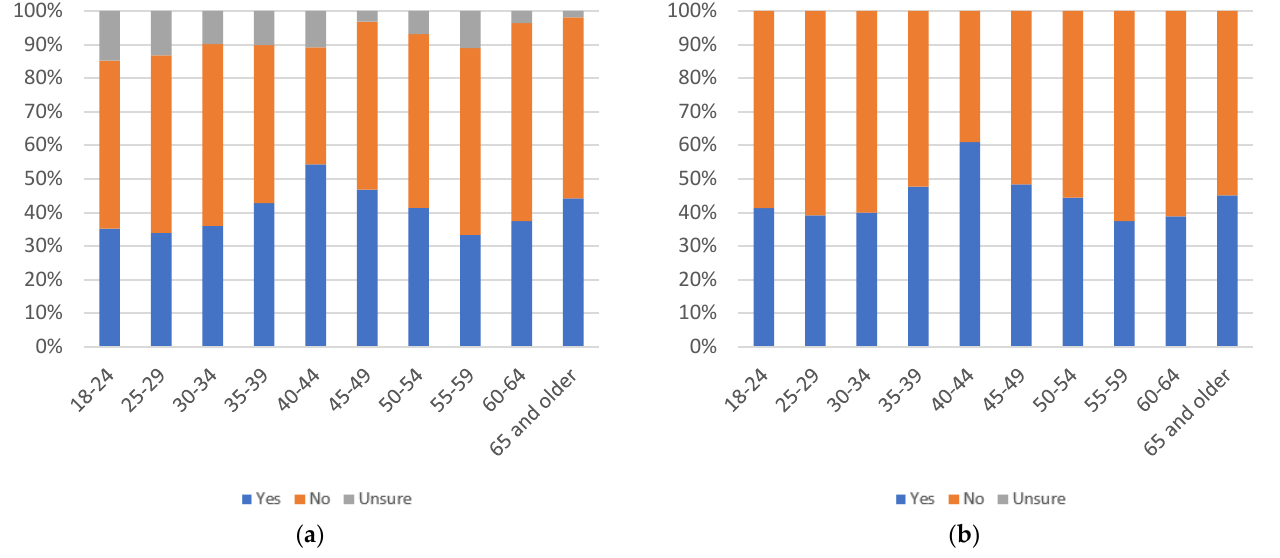
Figure 56. Label annoyingness, by age group: ( a ) with uncertain respondents (left) and ( b ) without uncertain respondents (right).